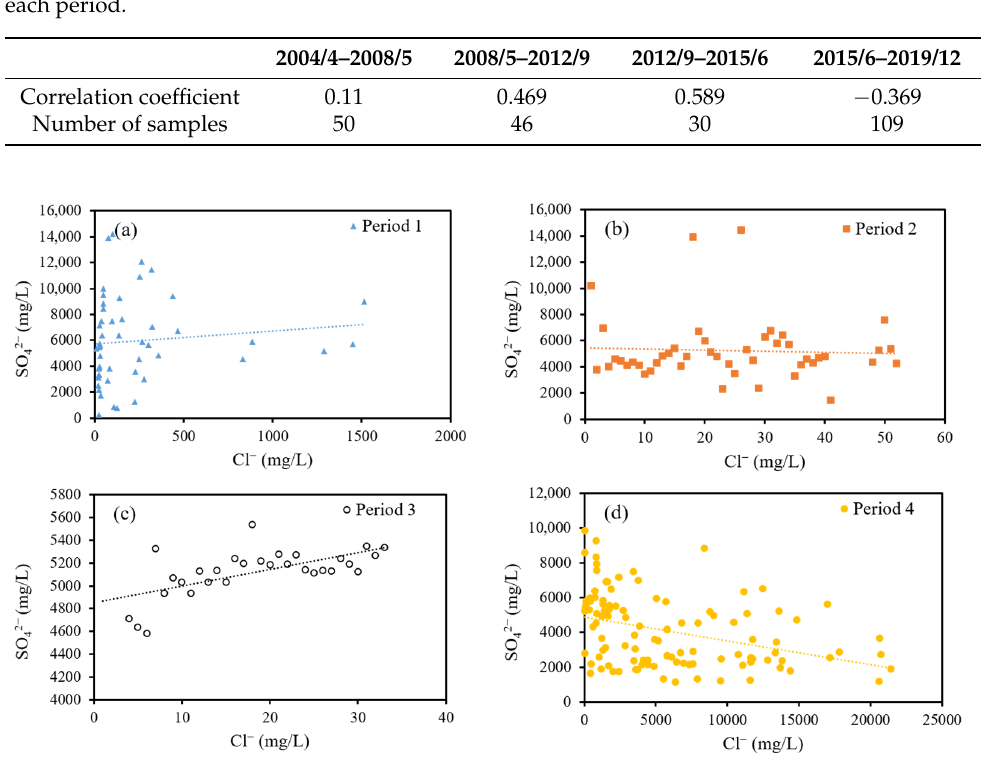
Figure 4. SO 42 − versus Cl − concentration of TYK thermal water in ( a ) period 1, ( b ) period 2, ( c ) period 3, and ( d ) period 4. Table 3. Summary statistics for SO 42 − in different periods.